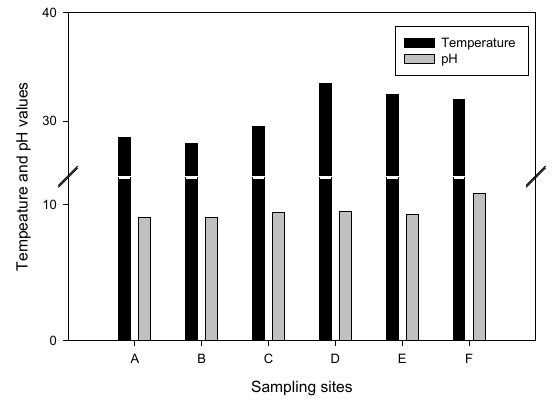
Figure 1: Temperature and pH values of wastewater samples